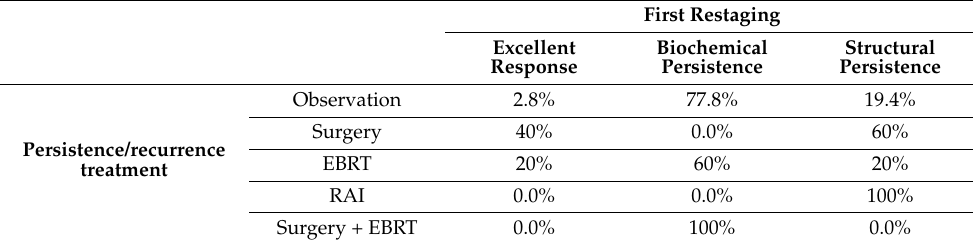
Table 5. Association between treatment for persistence/recurrence of disease guided by PET/CT imaging and first restaging data.